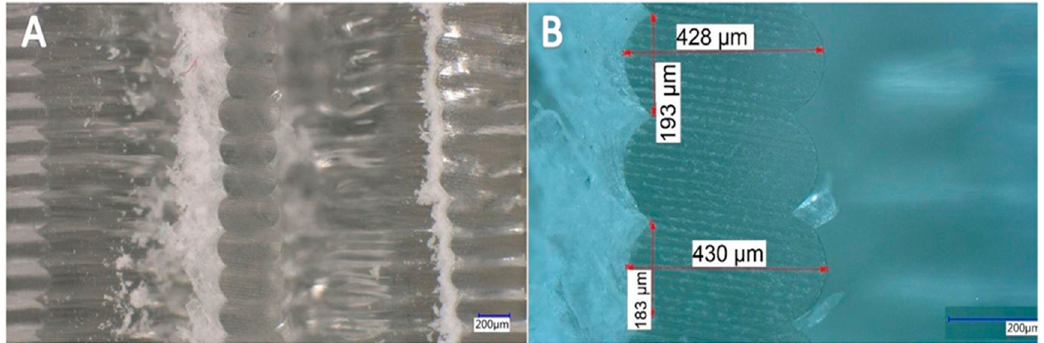
Figure 15. Microscopic cross-section image of 3D-printed sample with 2.4 ILD after compression test (cyclic loading–unloading). ( A ) 100× magnification setting, ( B ) 300× magnification setting.